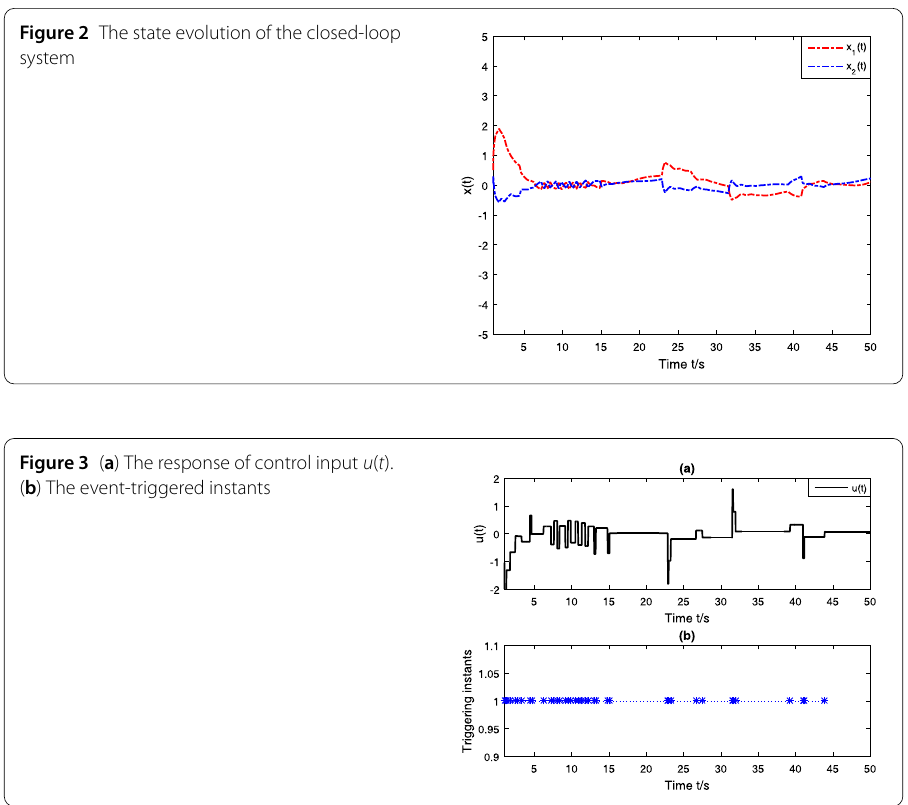
Figure 2 The state evolution of the closed-loop